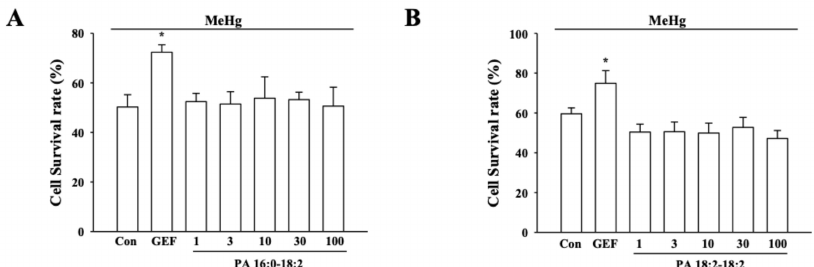
Figure 2. E ff ects of GEF, PA 16:0–18:2, PA 18:2–18:2 on MeHg-induced cytoxicity. ( A , B ) The indicated concentration of PA 16:0–18:2 and PA 18:2–18:2 have no e ff ects on MeHg-mediated cell death. MeHg (350 nM) was treated for 24 h. Data are presented as the mean ± SEM (n = 9; * p < 0.01, compared with untreated